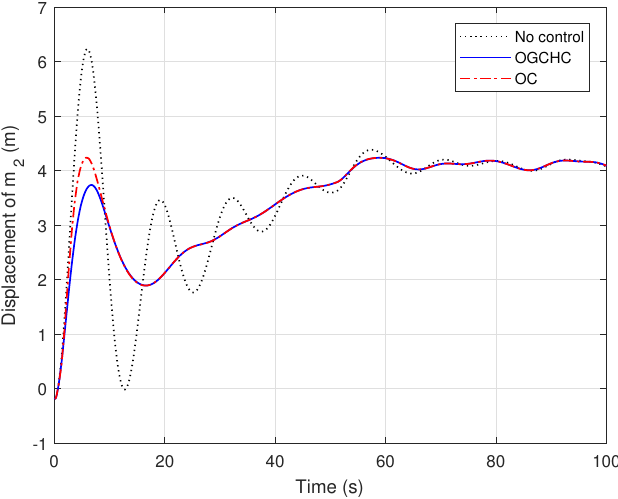
Figure 4. Displacement 2 of the riser without control, with OC and OGCHC under case